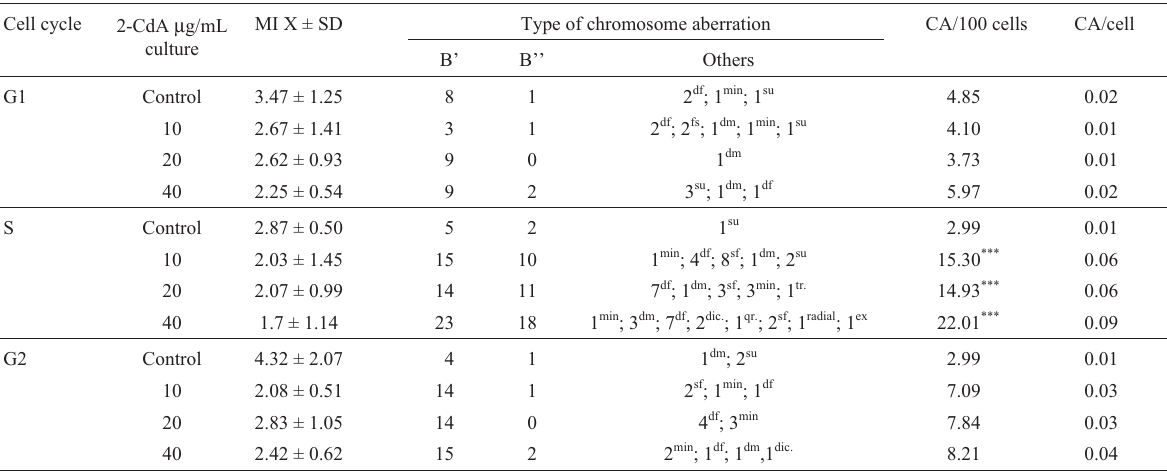
Table 1 - Chromosomal aberrations and mitotic index in human lymphocytes in culture treated with 2-CdA during G1, S and G2 of cell cycle. A total of 100 cells were analyzed per culture and 600 cells per treatment. Cell cycle 2-CdA µ g/mL